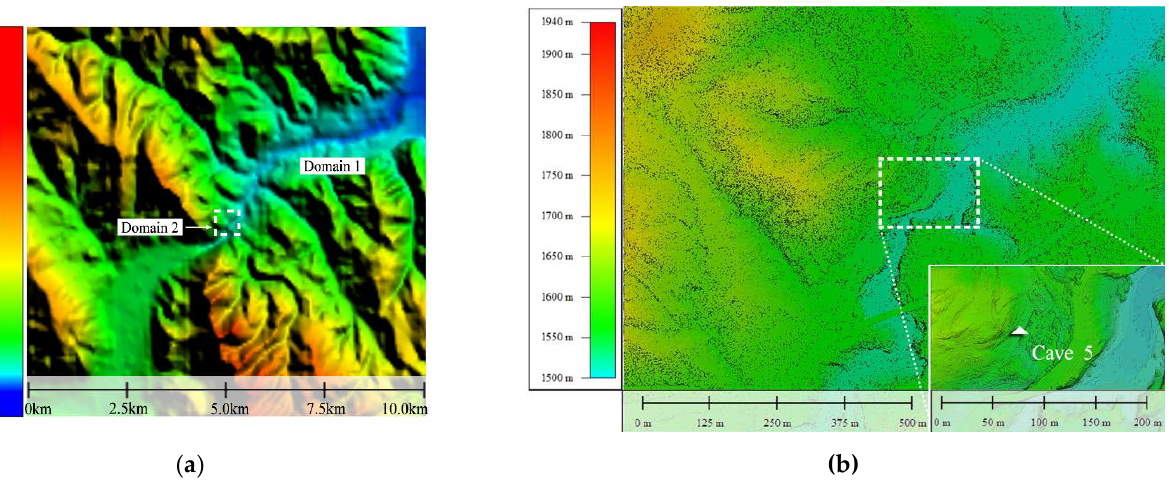
Figure 9. Computational domains ( a ): Domain 1 is the higher-level domain. Domain 2 is the current-